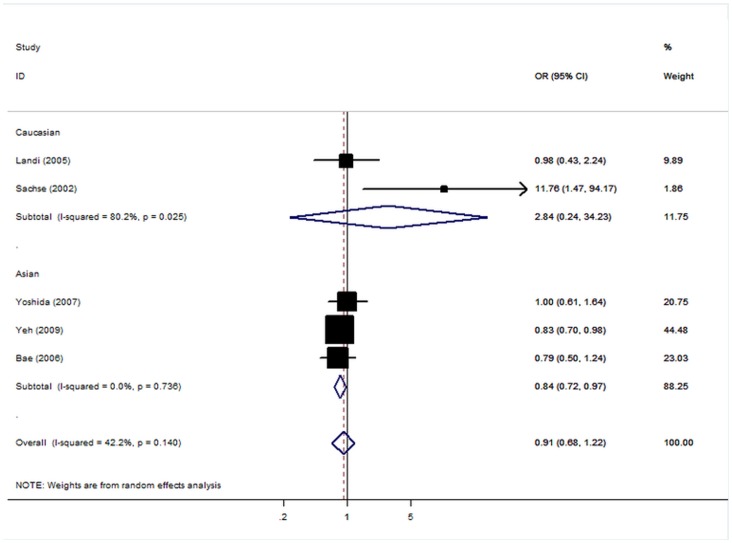
Forest plot from the meta-analysis of CYP1A2*C polymorphism and CRC risk.